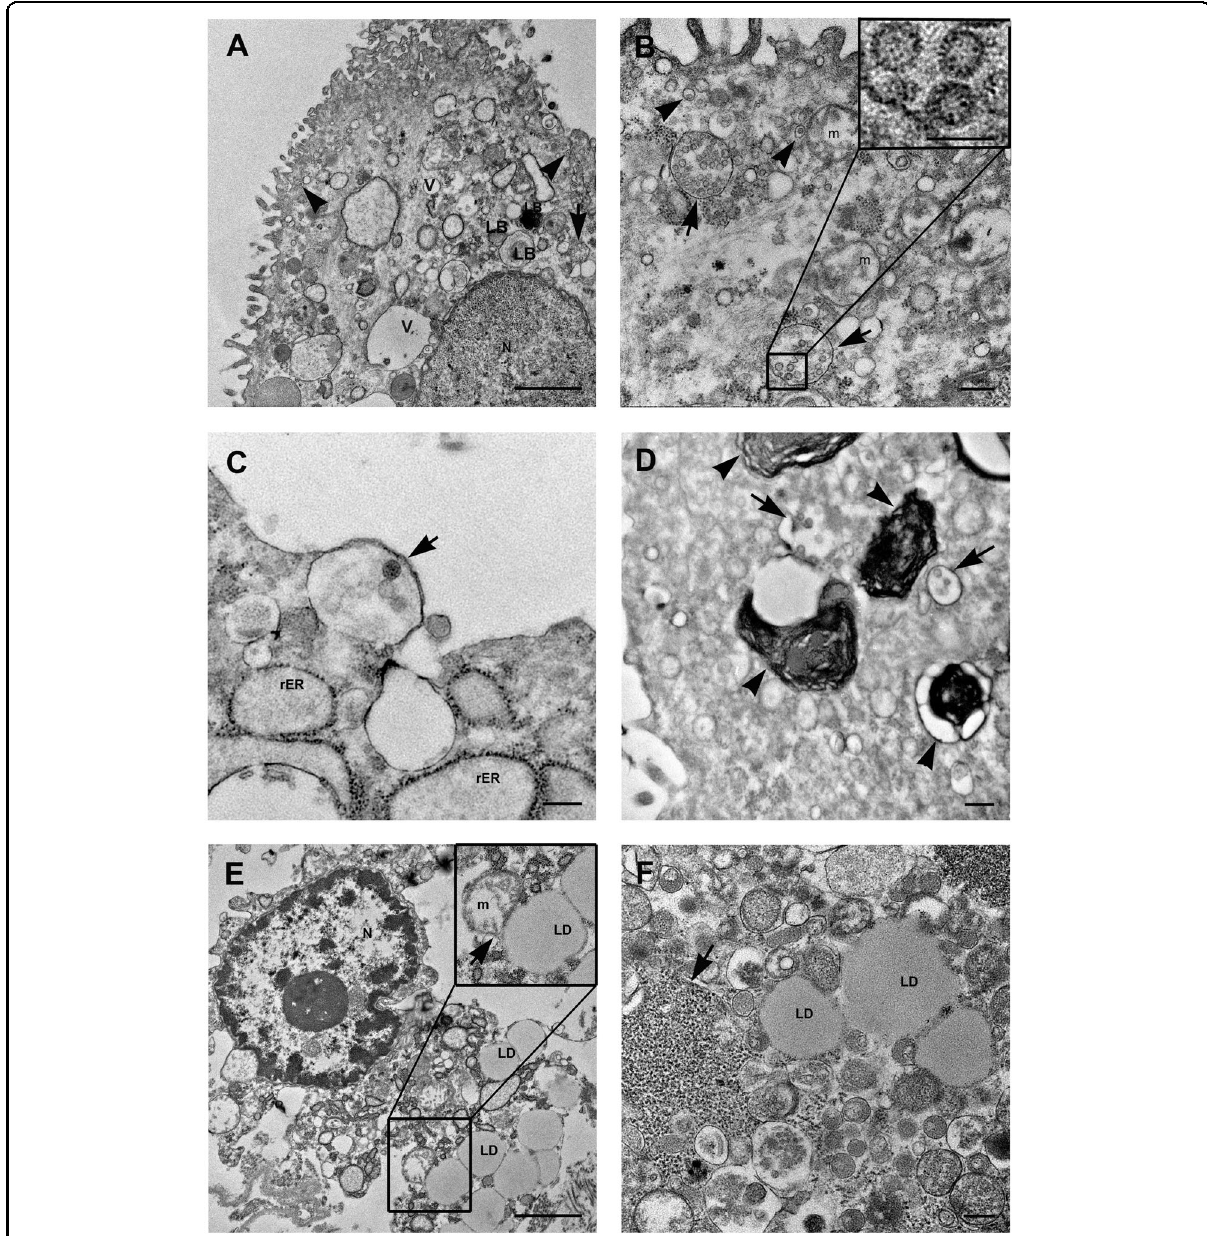
Fig. 6 SARS-Cov-2 detecting on lung tissue from COVID-19 patients by transmission electron microscopy. A , B SARS-CoV-2 particles are detected in type II pneumocytes recognizable by the presence of lamellar bodies, containing surfactant (LB). Viruses are localized in virus containing compartments (arrows). Other vesicles, very small in size, contain single viral particles (arrowheads). Numerous vacuoles (V) are present in the cell cytoplasm. B Mitochondria (m) display swelling with a reduction in membrane cristae amount. Higher magni fi cation of viral particles is visible in the boxed area: black dots are visible inside the viral particles due to cross section through the nucleocapside. C A vesicle containing viral particles (arrow) and enlargement of rough endoplasmic reticulum (rER) are shown. D Lamellar bodies, containing surfactant are visible (arrowheads). Arrows point to virus containing compartments. E , F Abundant lipid droplets (LD) are present inside lung cells. Mitochondria and LDs contacts sites were shown (arrow in insert panel). Free ribosomes are present in the cell cytosol, many of which are compartimentalized (arrow). N nucleus, m mitochondria, rER rough endoplasmic reticulum, LD lipid droplets, LB lamellar bodies, V vacuole. Scale bars: A , E = 1 μ m; B – D , F = 200 nm; boxed area in B = 100